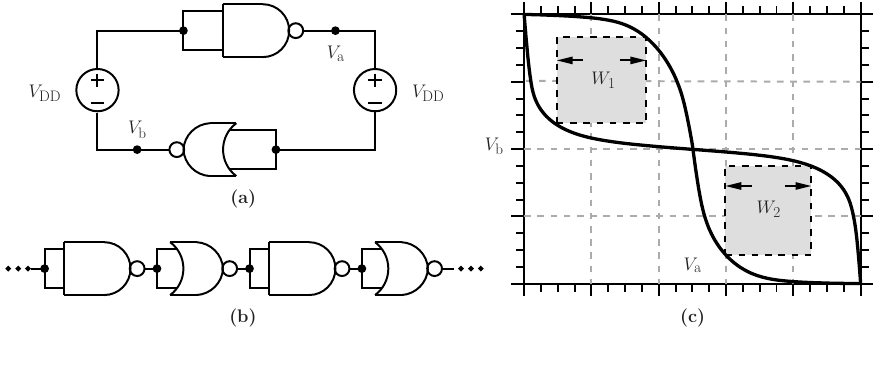
Figure 2. ( a ) Using a looped gate chain with feedback configuration to model a gate chain with infinite length in ( b ); ( c ) the voltage transfer curves (VTCs) of the gate pair are used in butterfly plots to determine the static noise margins (SNMs) [18].